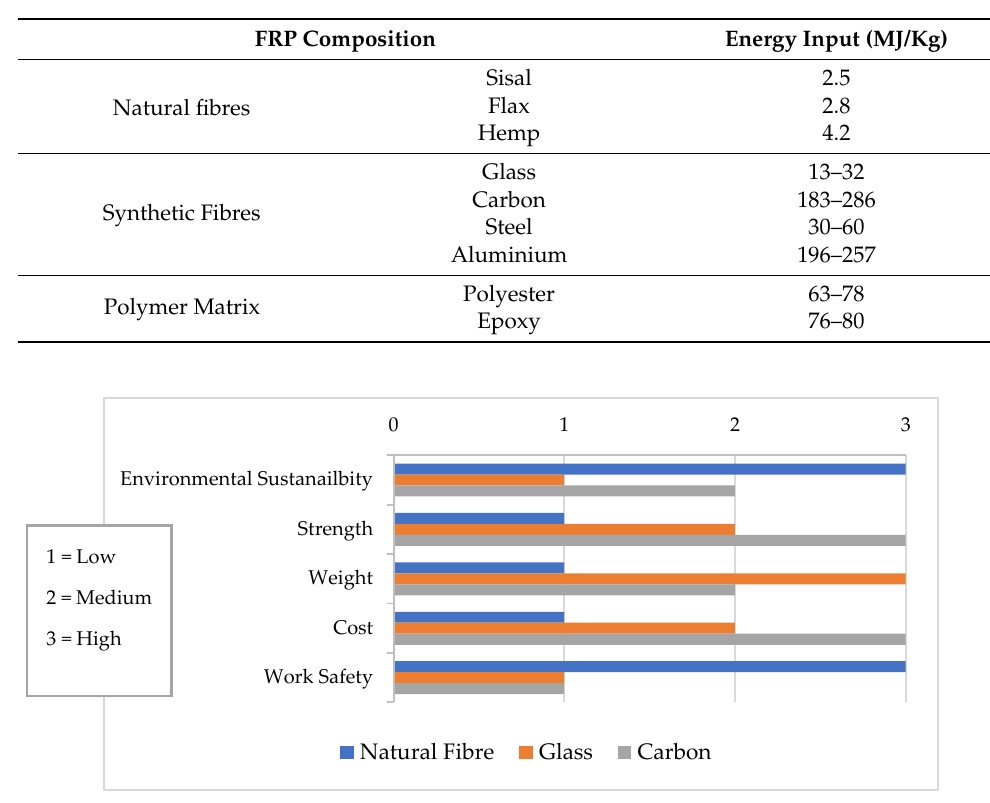
Figure 6. Economic, strength, and environmental comparison between natural and synthetic fibres [35,36].